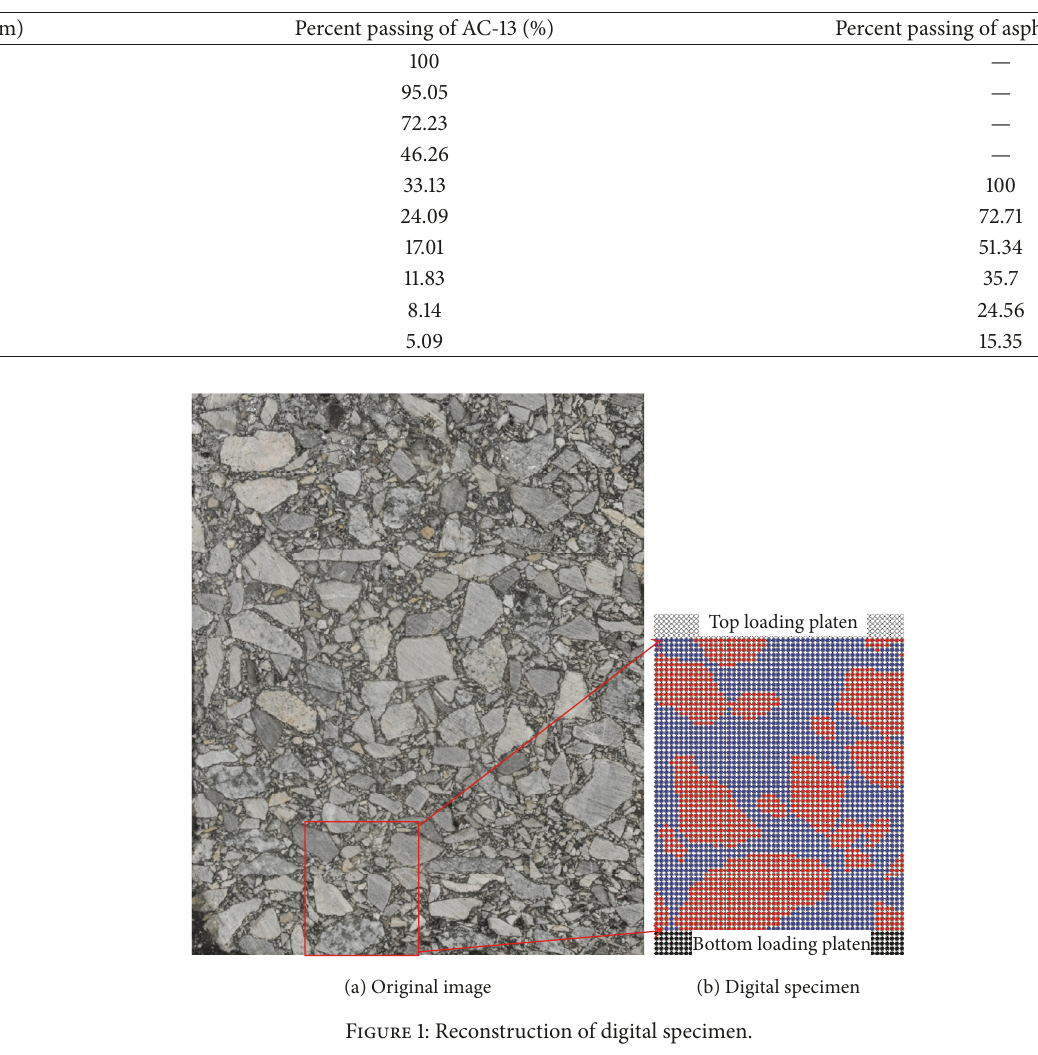
Table 3: Gradations of AC-13 asphalt mixture and mastic.